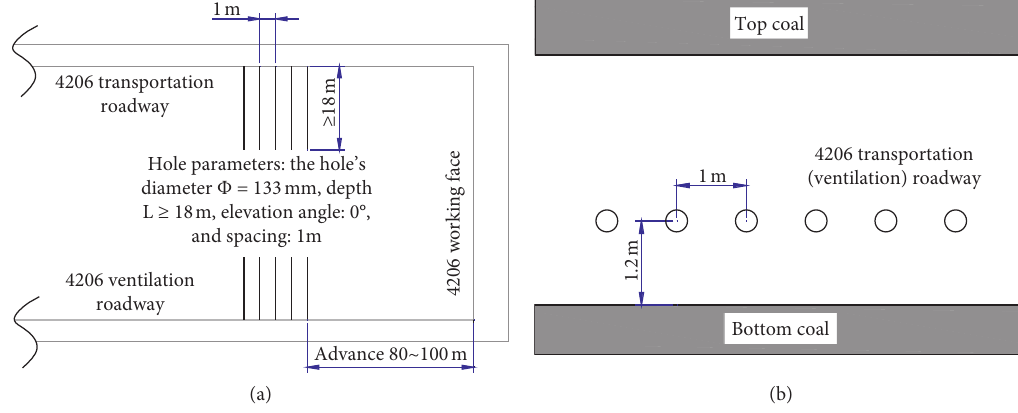
Figure 11: Layout of large-diameter holes. (a) Plan. (b) Profile.